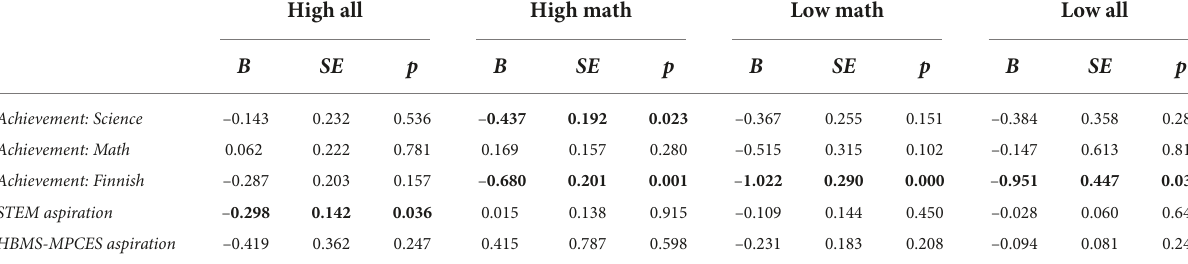
TABLE 5 Gender effect on outcomes within